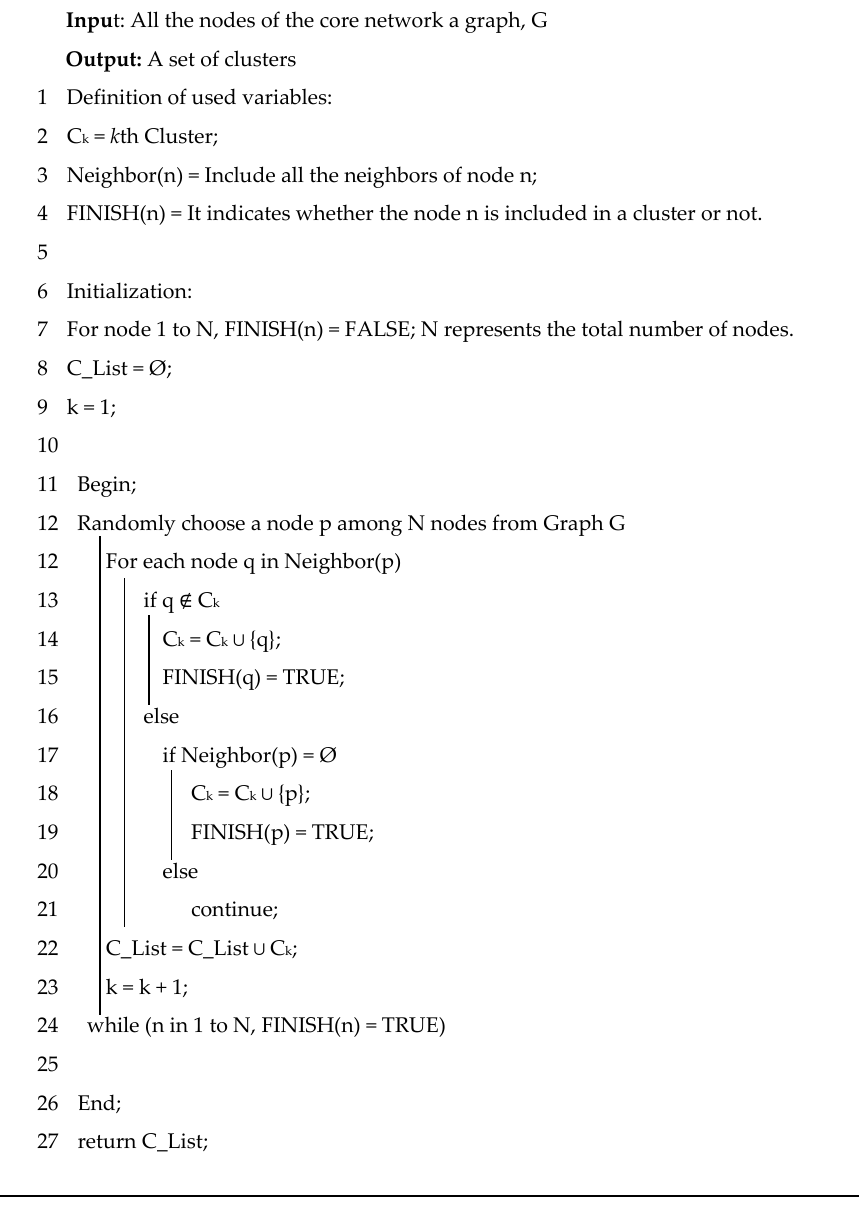
Algorithm 1: An algorithm to make clusters (G). Algorithm 1 : An algorithm to make clusters